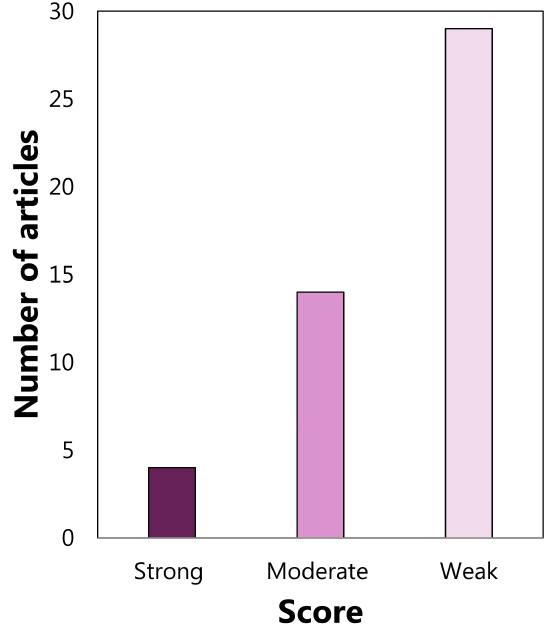
Figure 12. Global rating of articles on